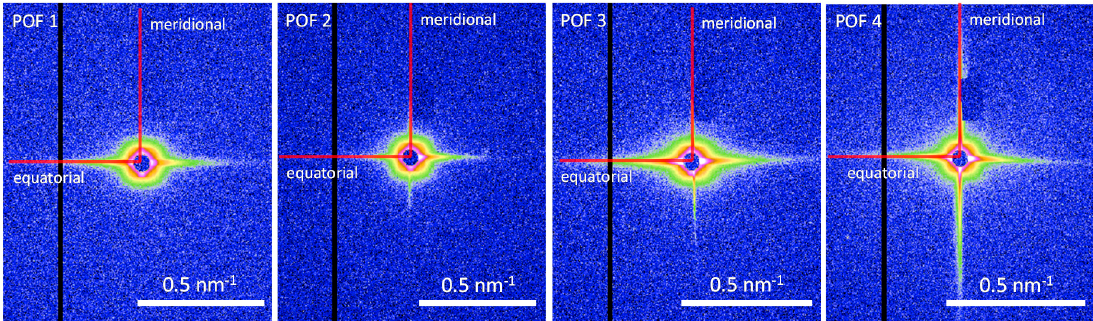
Figure 4. 2D SAXS intensity distributions of the four PMMA POF samples. The anisotropic equatorial and meridional scattering is present in all samples, but clearly different, which indicates a high sensitivity of the fiber nanostructure to changes in the production processes.